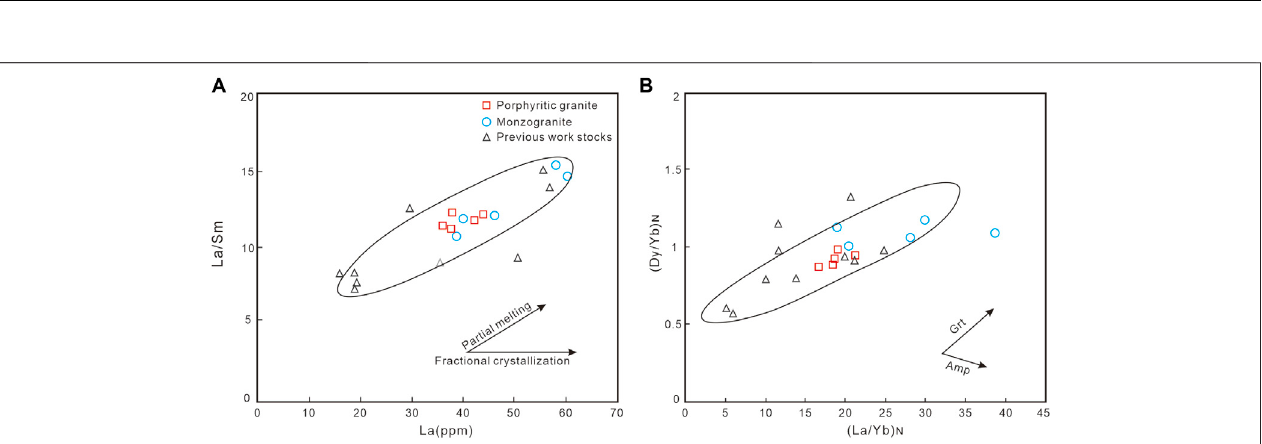
FIGURE 7 | Zircon ε Hf (t)-t diagram of Yaozhuang stock (A) and t DM2 statistical histogram (B) (data after Dong et al., 2011a; Ke et al., 2012b; Liu et al., 2014; Zhao et al., 2021).